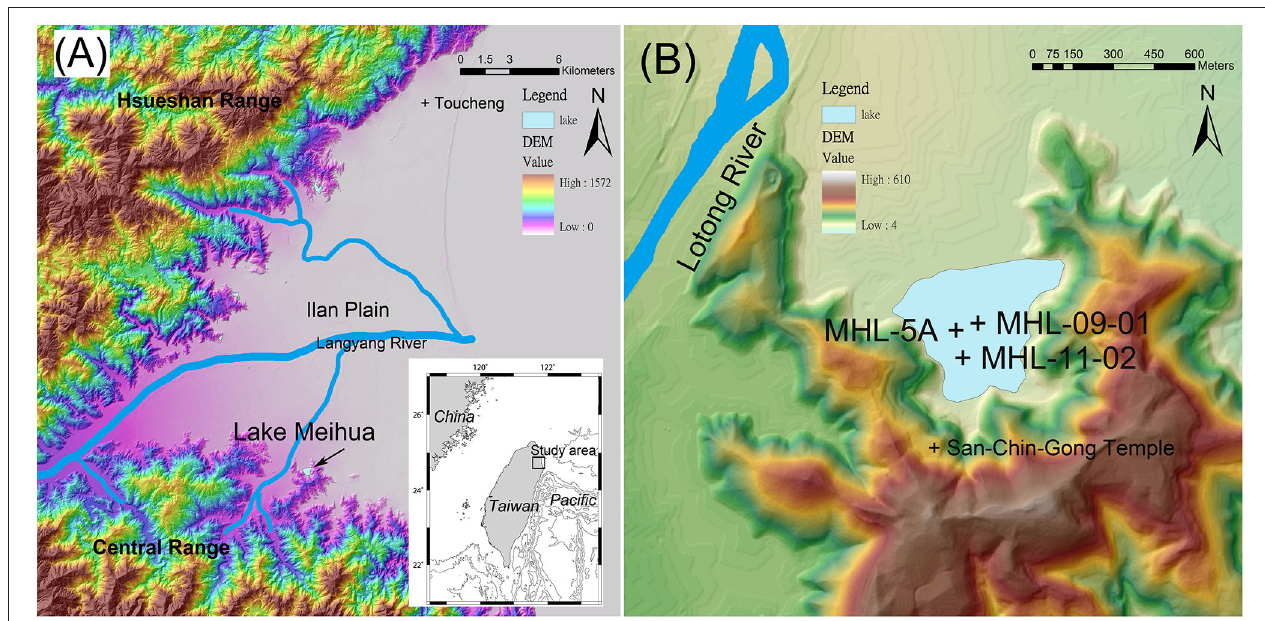
FIGURE 1 | (A) Digital elevation model (DEM) of the Ilan Plain showing the location of the Lake Meihua. The inset map shows the location of Ilan Plain in northeastern Taiwan. (B) Locations of the sediment cores investigated in this study, the topographic map is based on 40m